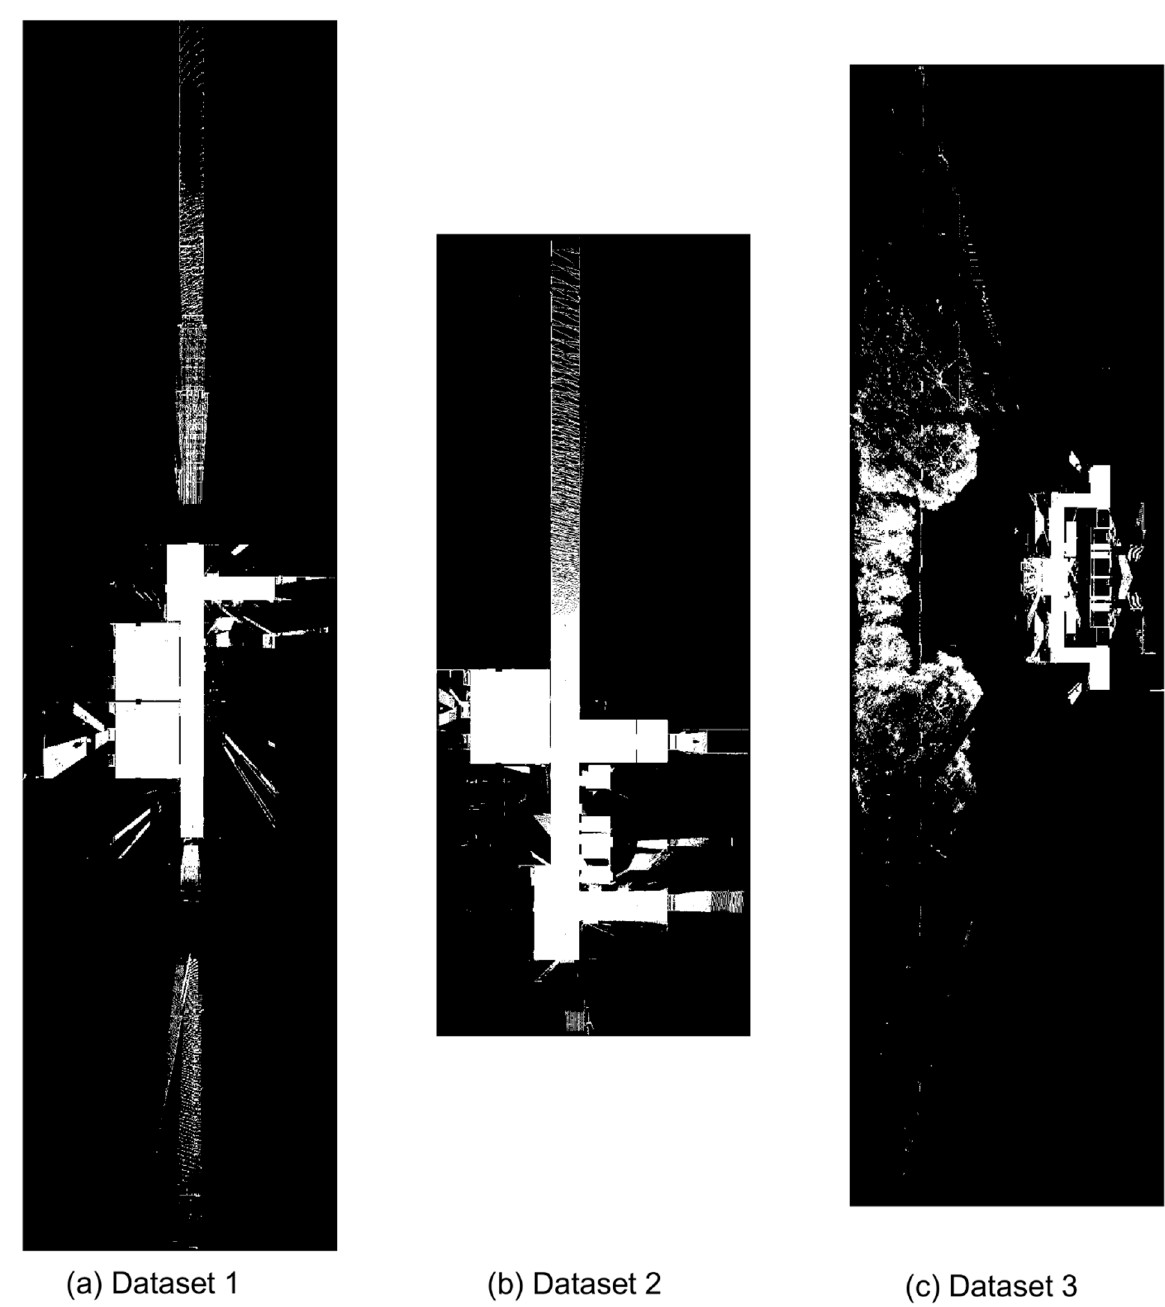
Figure 3. The initial binary mask images for the point clouds (ground/floor level data points removed) considered: ( a ) dataset 1, ( b ) dataset 2, and ( c ) dataset